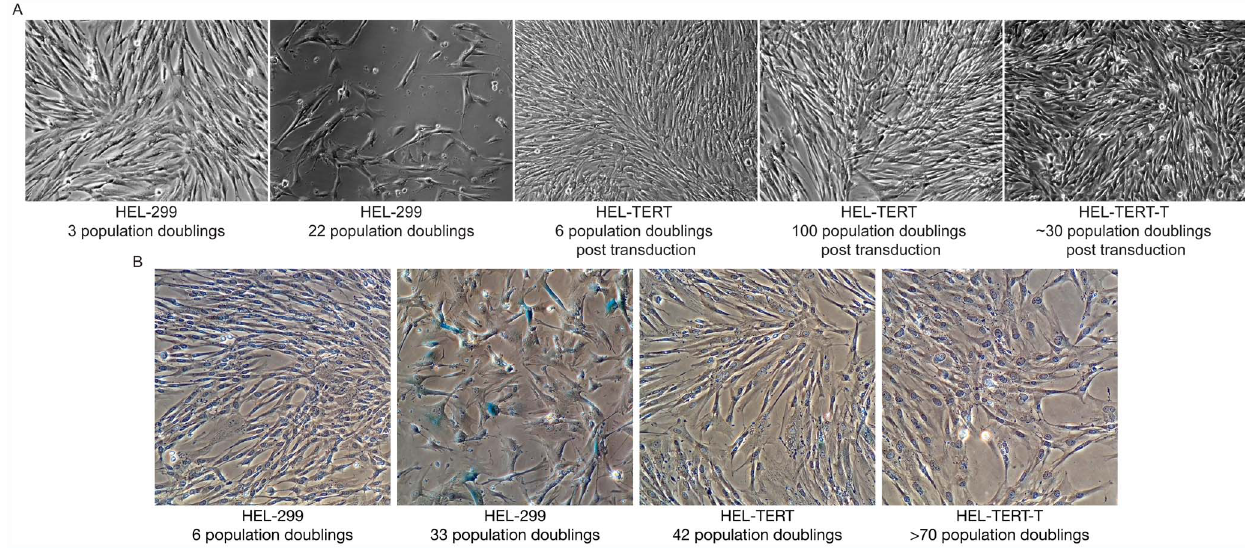
Figure 3. HEL-299, HEL-TERT, and HEL-TERT-T cell morphology and senescence. A. Transduction of HEL-299 cells with hTERT does not alter morphology. Light microscopy of live HEL-299 cells at 3 (left panel) and 22 population doublings (left middle panel), HEL-TERT cells after 6 (middle panel) and 100 (right middle panel), and HEL-TERT-T (far right panel) after approximately 30 population doublings. B. HEL-TERT cells fail to exhibit at least one sign of senescence. HEL-299 cells at 6 (left panel) and 33 (left middle panel), HEL-TERT cells after 42 (right middle panel), and HEL- TERT-T cells at approximately 70 (right panel) population doublings were stained for b -galactosidase activity.